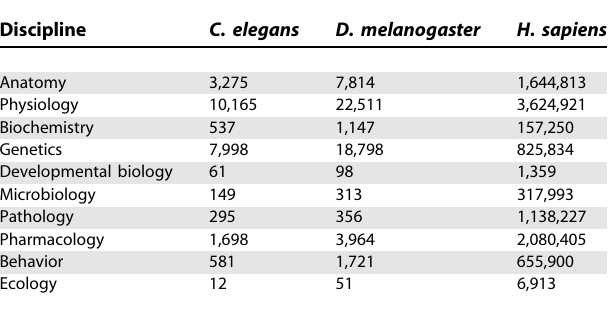
Table 1. Some Reasons Why Homo sapiens Will Become THE model Organism of the 21st Century: PubMed Citations